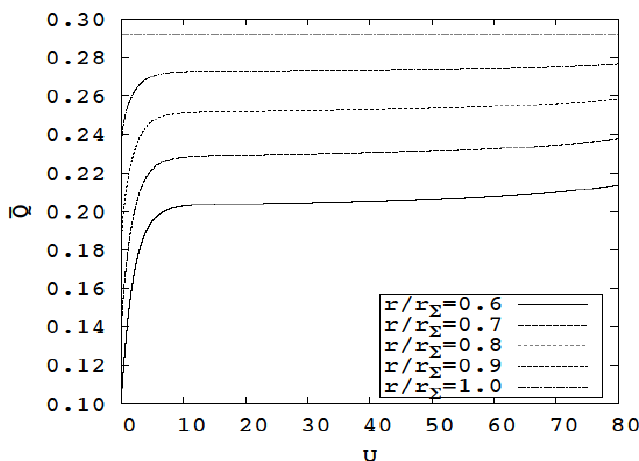
Figure 6. Radiation flux (multiplied by 10 2 ).